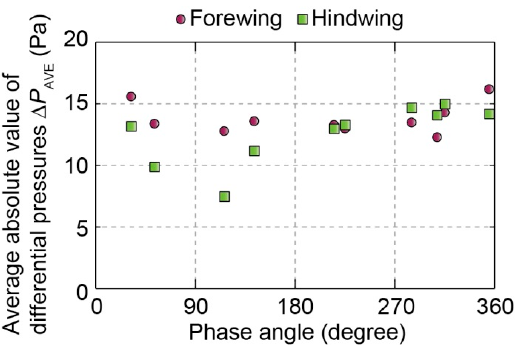
Figure 6. Relationship between the phase angle of the ornithopter and averaged absolute values of differential pressure for each stroke.